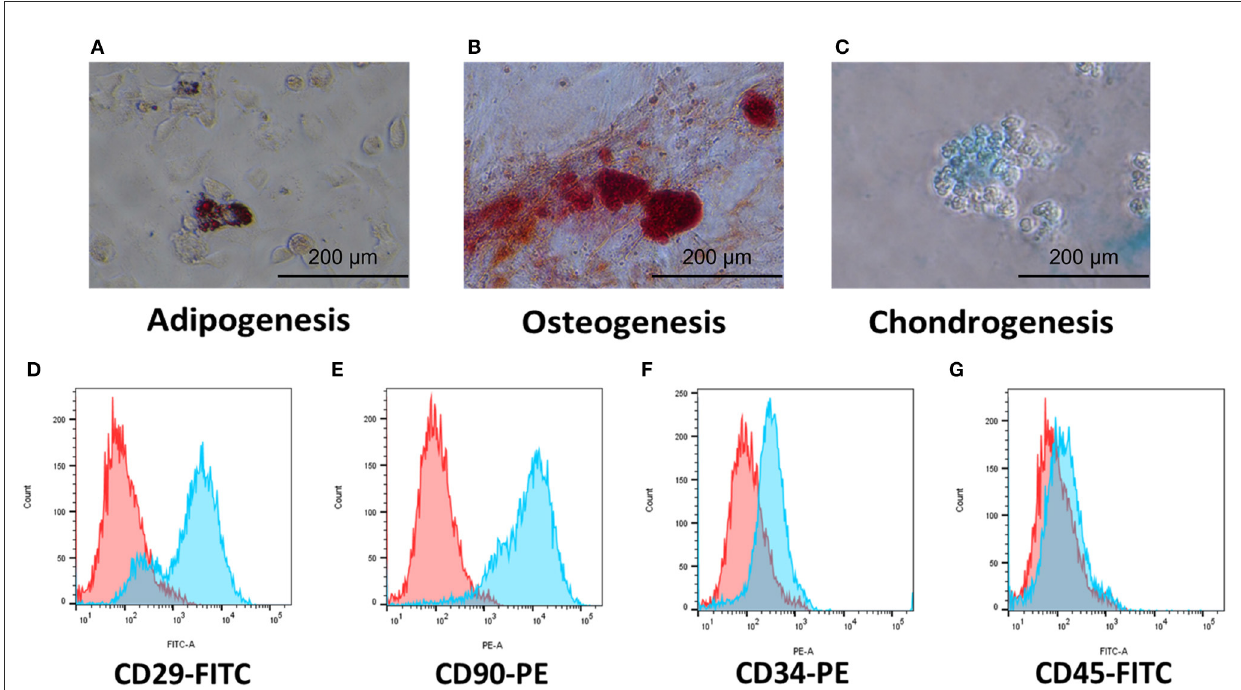
FIGURE1 Characterization of cAT-MSCs isolated from canine adipose tissue. (A–C) Trilineage potential of cAT-MSCs. Differentiation into adipocyte, osteocyte, and chondrocyte was confirmed via Oil Red O, Alizarin Red, and Alcian Blue staining, respectively. (D–G) Flow cytometry analysis of cell surface markers. cAT-MSCs expressed CD29 and CD90 and lacked CD34 and CD45. (Blue: stained marker, red: unstained negative